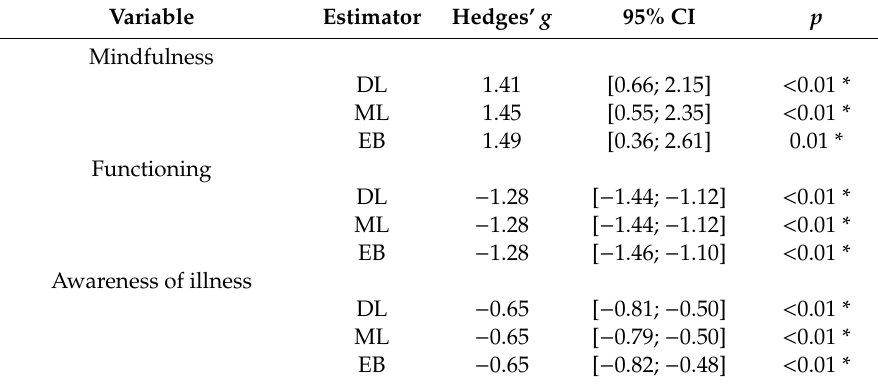
Figure 11. Funnel plot of the negative symptoms variable (pretest–posttest).